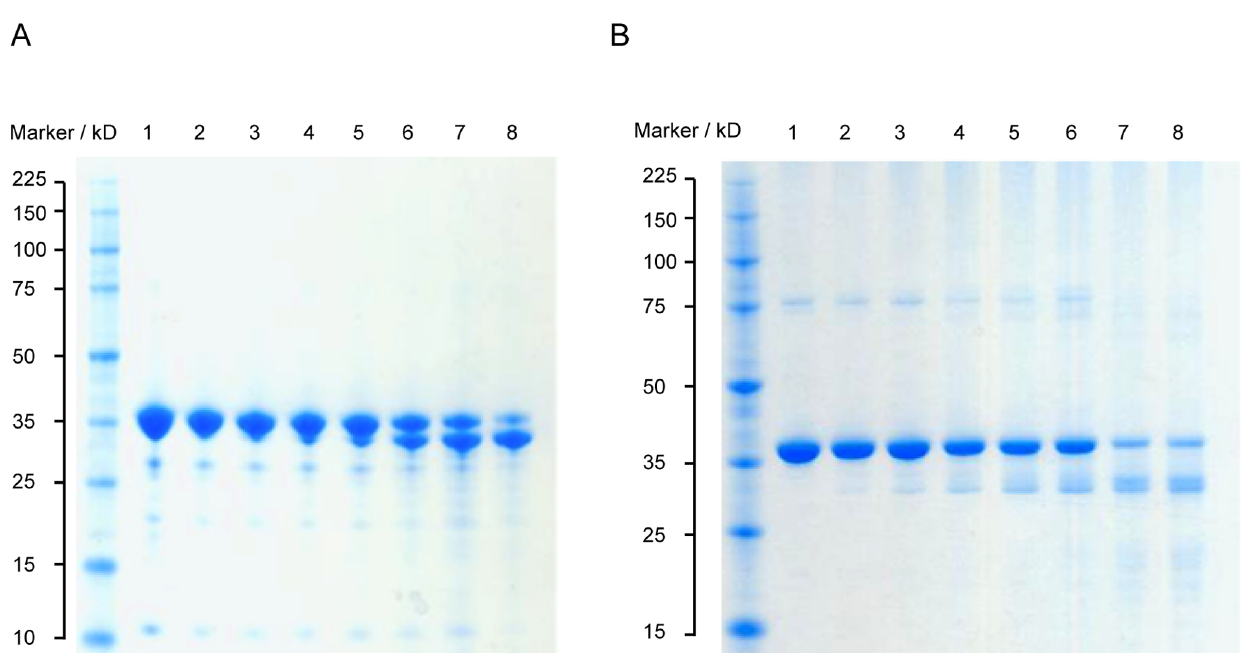
Figure 2. Prostate specific antigen (PSA) assay. Engineered CBG variants were incubated with PSA. In both gels, Lane1: uncleaved CBG; Lane 2: 2 hours incubation with PSA; Lane 3: 4 hours incubation with PSA; Lane 4: 8 hours incubation with PSA; Lane 5: 16 hours incubation with PSA; Lane 6: 24 hours incubation with PSA; Lane 7: 48 hours incubation with PSA; Lane 8: 72 hours incubation with PSA. (A) Of the two variants of PSA-sensitive CBG, the one with the reactive centre loop sequence EEGVDTAGSSYYSGNLTSKPII is cleaved the more rapidly. (B) CBG-EEGVDTAGSALLSSDITSKPII.